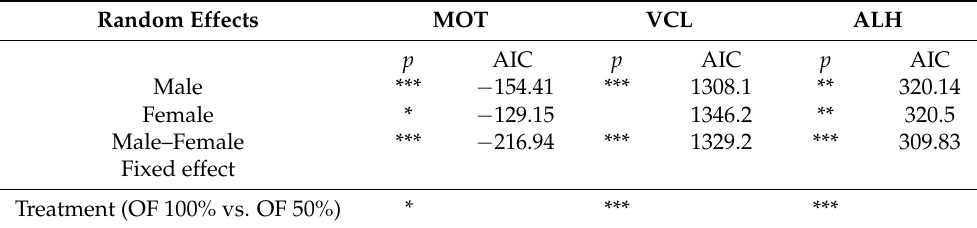
Table 2. Selection of the best-fitting model for Mixed Model ANOVAs isolating the OF groups, with the treatment (OF 100% vs. OF 50%) as a fixed factor and male, female or their interaction as random factors. Only the parameters with significative differences among treatments are shown.